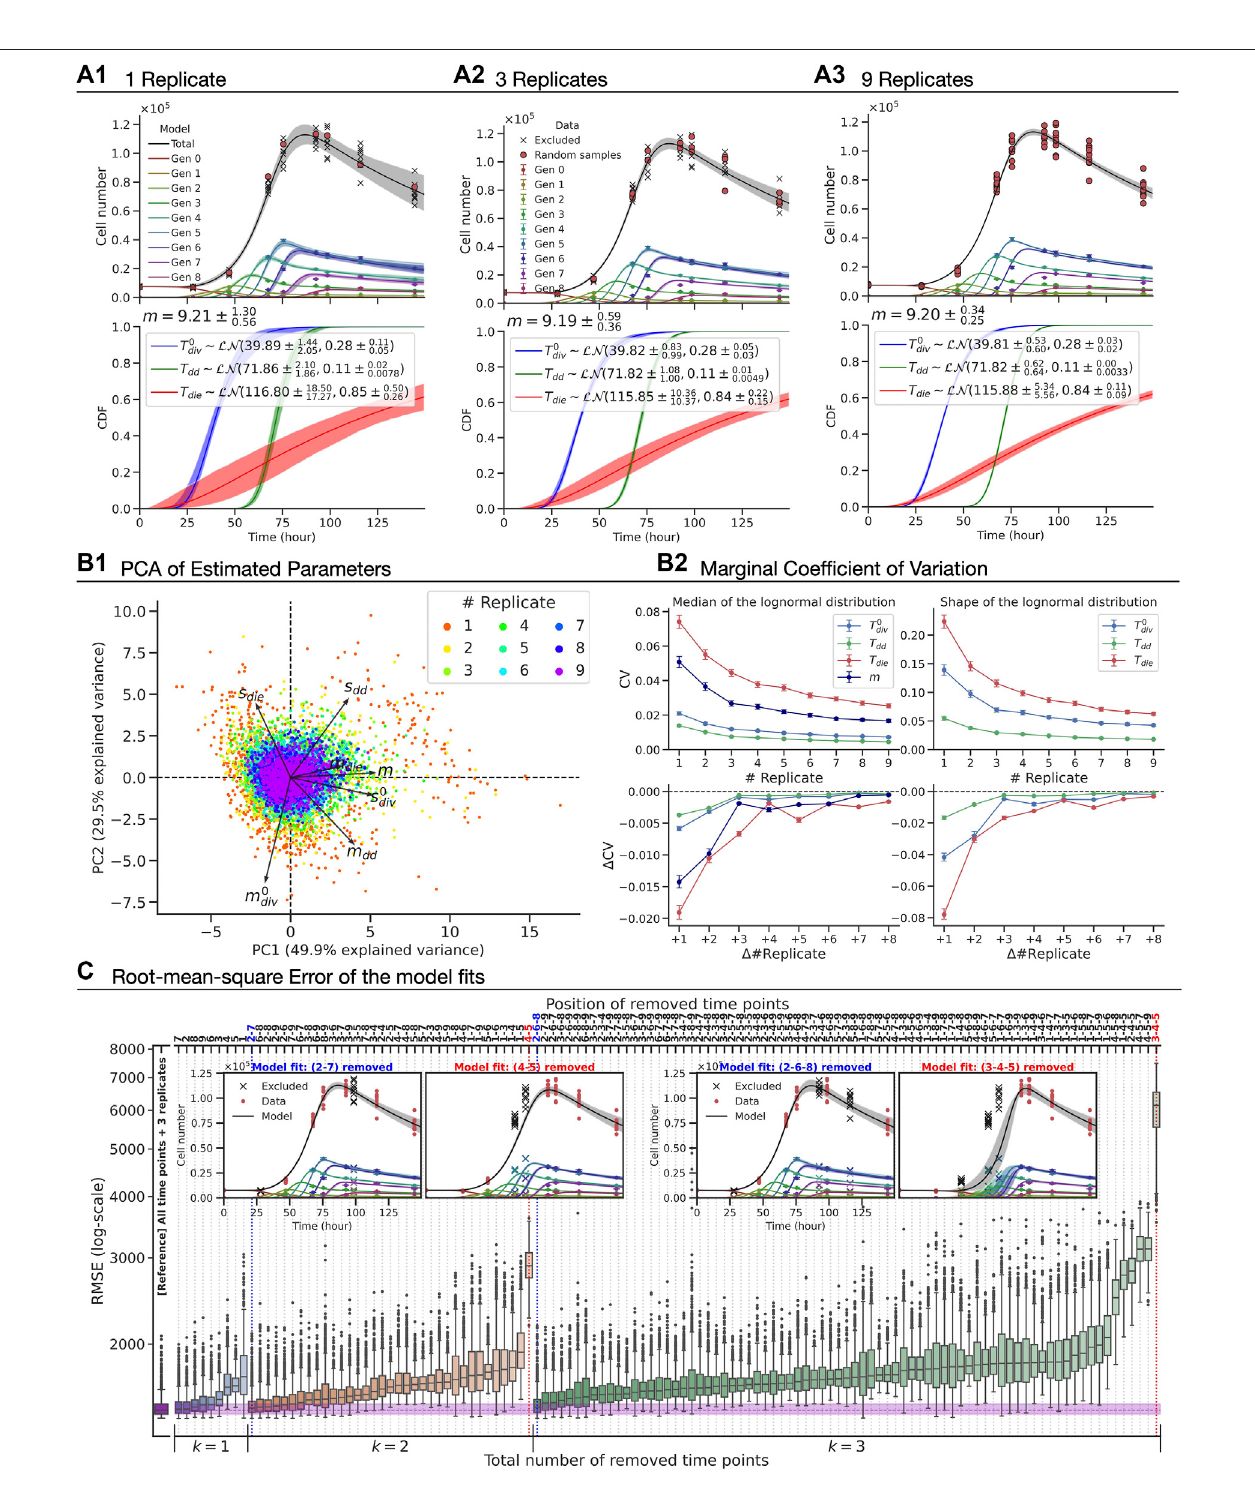
FIGURE 5 | The precision of the parameter estimates and the accuracy of the model fi t with CpG-stimulated Bim − / − murine B cell FACS data. (A1 – A3) The best- fi t model (top) ,whichhasseven fi ttedparameters(bottom): T 0 div ∼ LN ( m 0 div , s 0 div ) , T dd ∼ LN ( m dd , s dd ) , T die ∼ LN ( m die , s die ) and,subsequentdivisiontime, m .Foragiven replicate number, the model was fi tted to 1,000 synthetic datasets, which were created by randomly sampling the original data with replacement per time point. (B1) From the sets of estimated parameter vectors, biplot of principle component analysis (PCA) result is shown. (B2) The marginal coef fi cients of variation (CV) was calculatedwith95%con fi denceintervalfrombootstrapping. (C) Theroot-mean-squareerror(RMSE)wasevaluatedoverallavailabledatapointsafter fi ttingthemodelto thesyntheticdatasets.Thereference(purple)wasobtainedafter fi ttingthemodeltodatasetsassumingonlythreereplicatesareavailablewhilemaintainingalltimepoints. Examples of the best (blue) and worst (red) fi ts are shown for 2 and 3 time-points being removed.